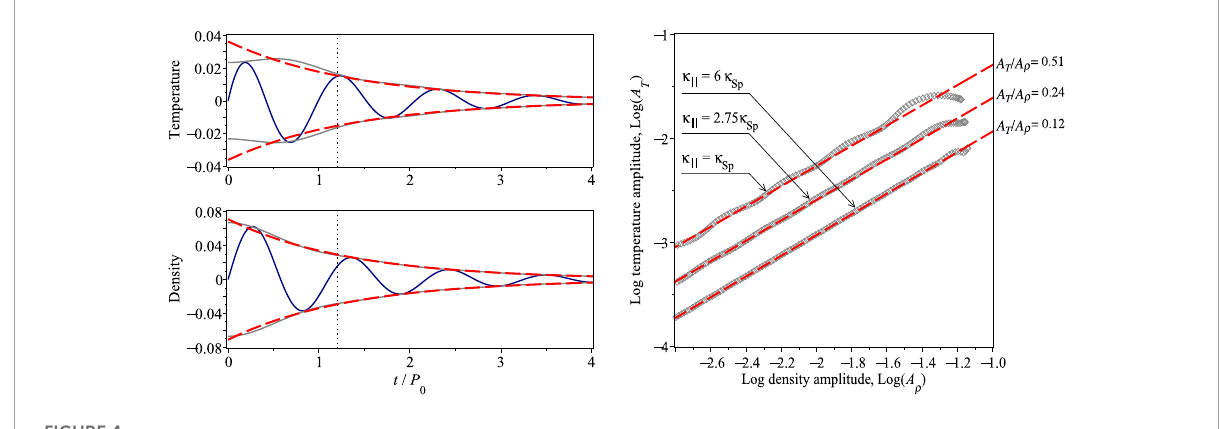
FIGURE 4 The time profiles of the temperature and density perturbations by a standing slow wave, obtained numerically from Eqs 1 – 4 at z = 0 . 1 λ , for κ ‖ = κ Sp , and normalised to T 0 and ρ 0 , respectively (left). The envelopes of the temperature and density perturbations are obtained with the Hilbert transform (grey solid) and by exponential fitting (red dashed). The vertical dotted lines in the left panels indicate the apparent transition time from a non-exponential to exponential damping. The right panel shows examples of the amplitude ratios for several values of κ ‖ (shown in the inlet), estimated with the Hilbert transform (grey diamonds) and by exponential fitting (red dashed). Mind the logarithmic scale in the right